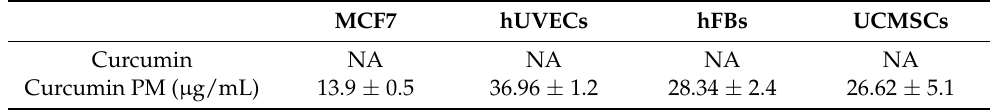
Table 1. The IC 50 values of free curcumin and curcumin PM on different cell types (ND: not not